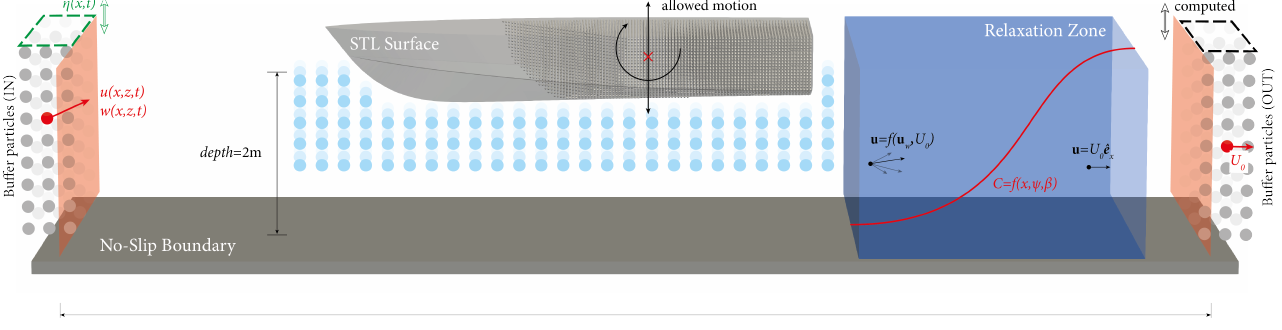
Figure 3. Numerical wave flume implemented in DualSPHysics with details of the principal